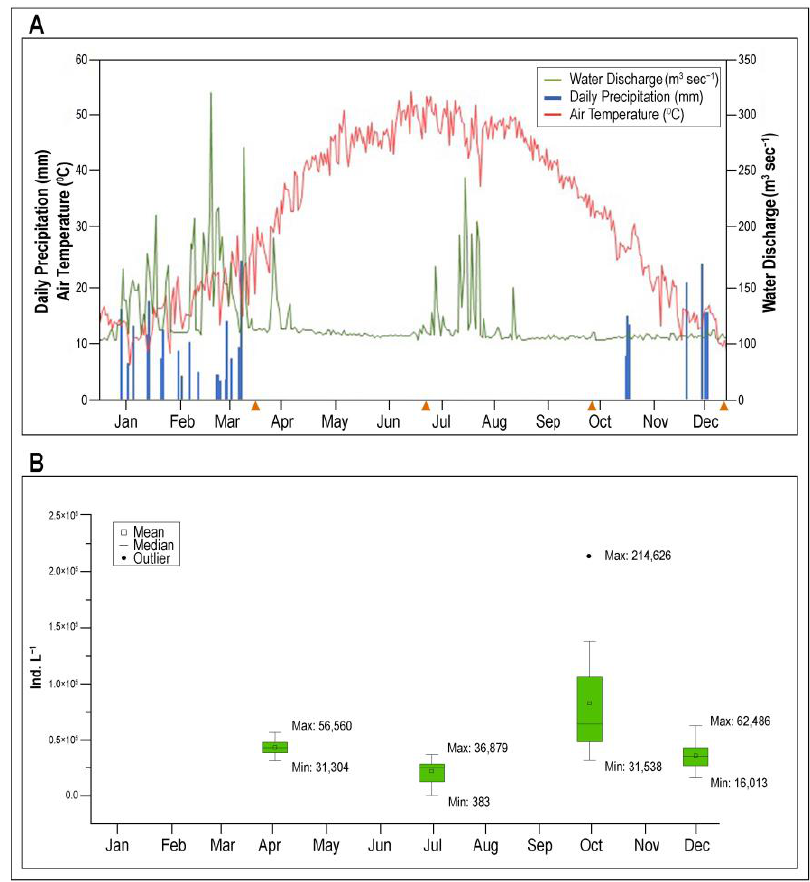
Figure 3. ( A ) Temperature, precipitation, and water discharge rate through the city of Mosul during 2021. The symbols “ ▲ ” designates the sampling dates; ( B ) total abundance of algal taxa in the sampling dates.